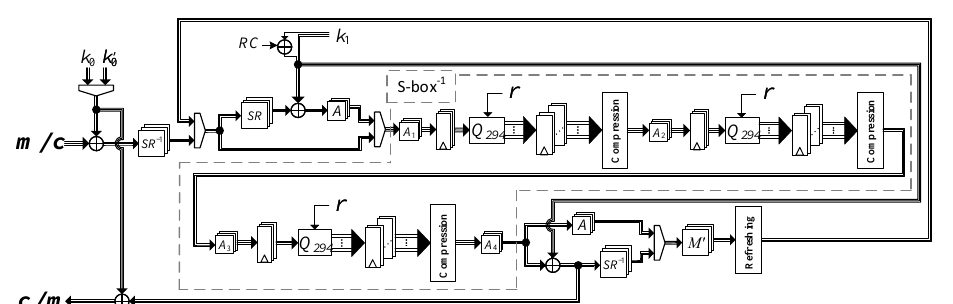
Figure 10: Design architecture of our round-based second-order Prince encryp- tion/decryption